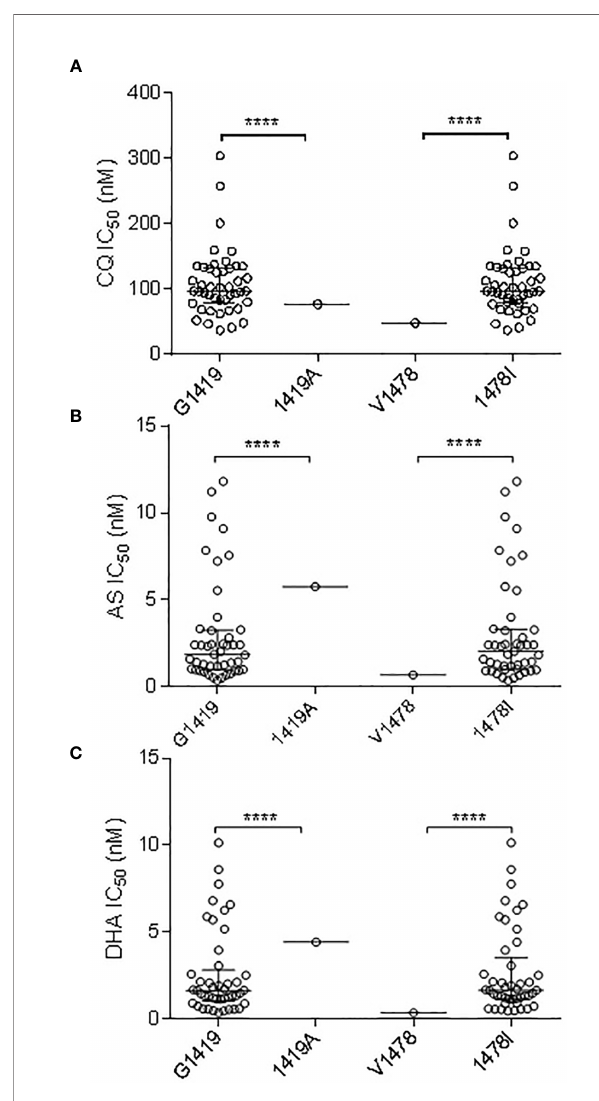
FIGURE 3 | Correlation Association of SNPs in pvmrp1 with ex vivo susceptibilities to CQ (A) , AS (B) , and DHA (C) . **** represents indicate signi fi cant differences between the two alleles at P <